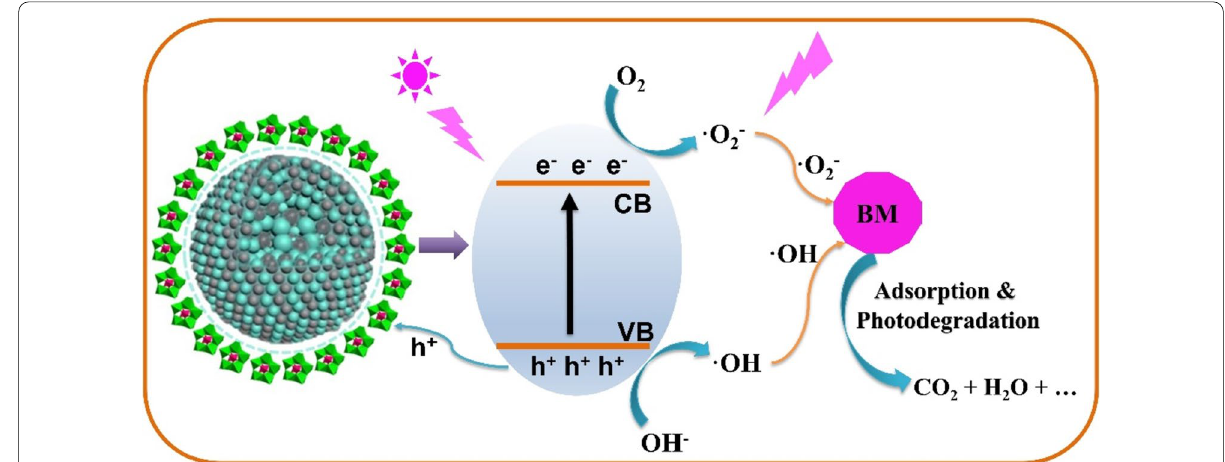
Fig. 10 Schematic illustration of removal of BM by AgZnO/POMs